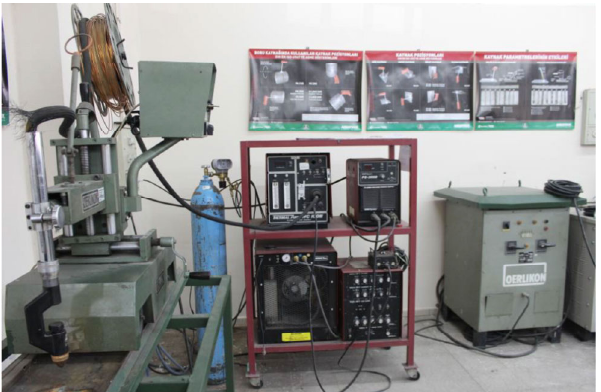
Fig. 4. Wear tests were performed at 19.62, 39.24, and 58.86 N using a load applied in the normal direction.